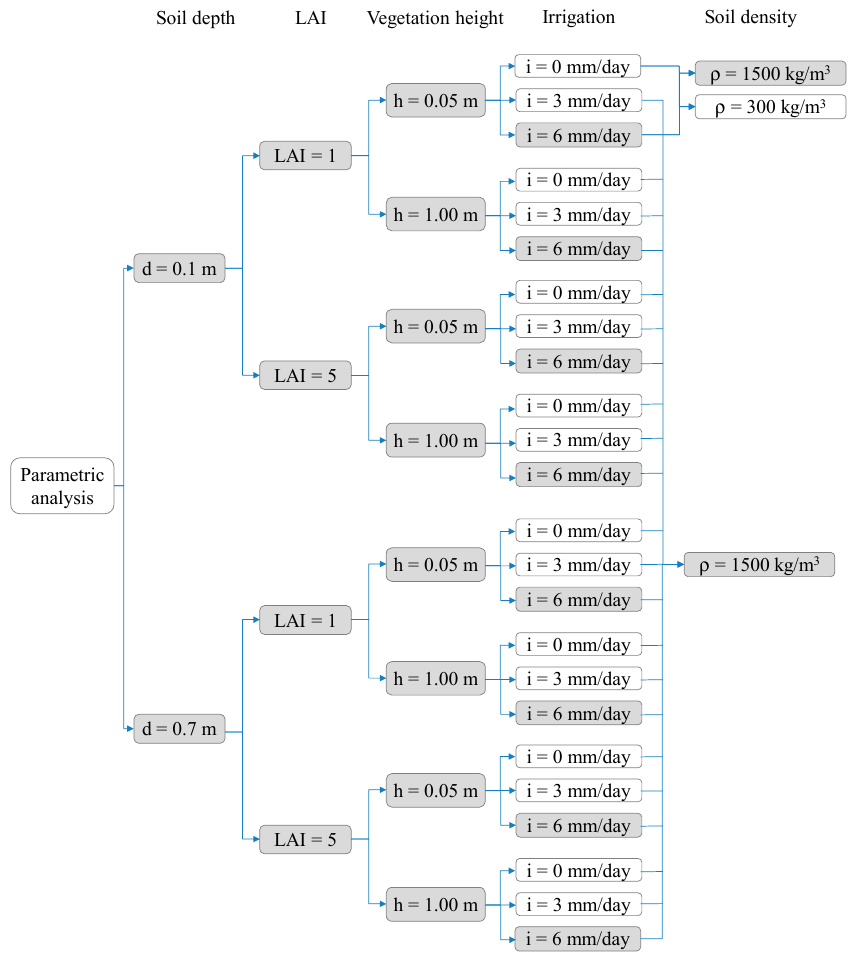
Figure 5. Flowchart of the parametric analysis (highlighted in grey are the combinations used to assess the impact of vegetation and substrate).